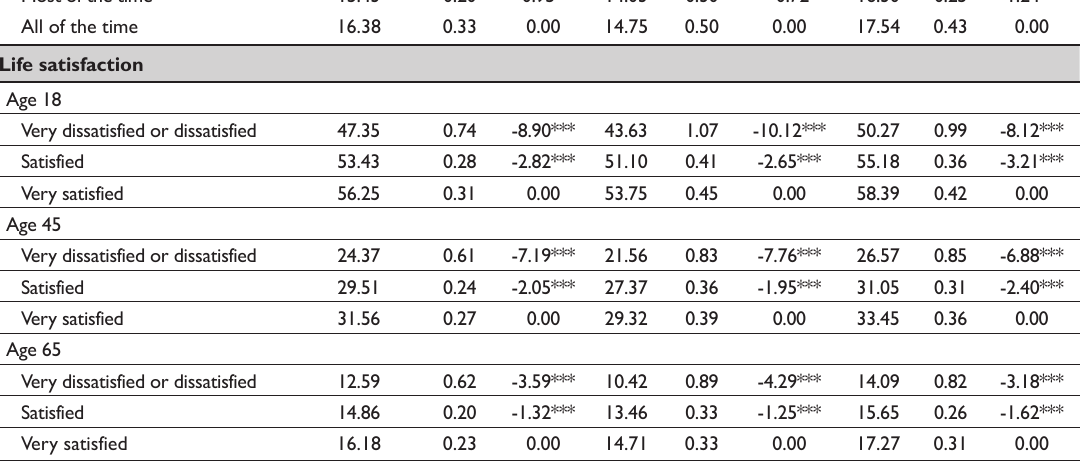
LE=life expectancy. Dif.=Differences from reference group. 1 Differences in life expectancy between males and females for all variables were statistically significant (p<0.001). *** P <0.01; **P<0.05;